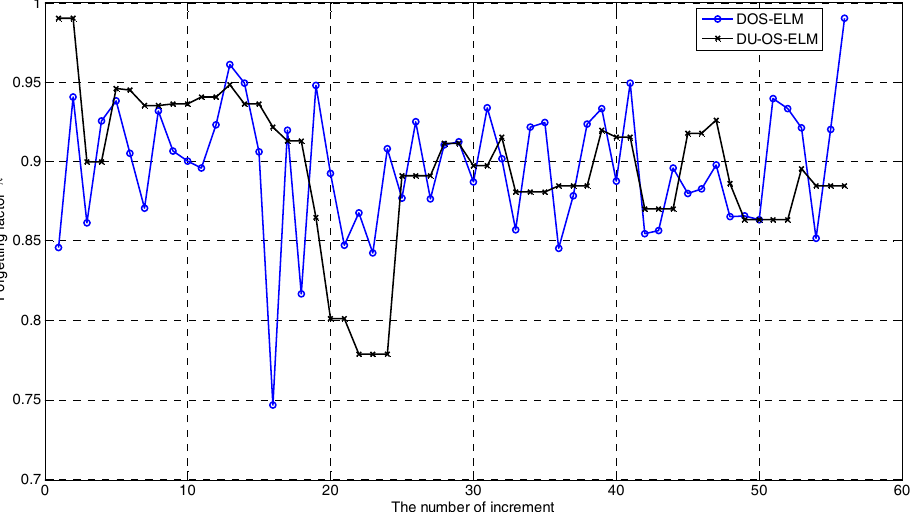
Sensors 2017 , 17 , 1847